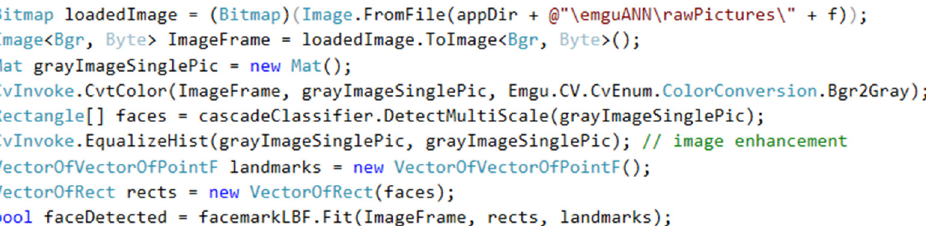
Figure 4. Viola–Jones facial extraction and landmark algorithm (own creation).